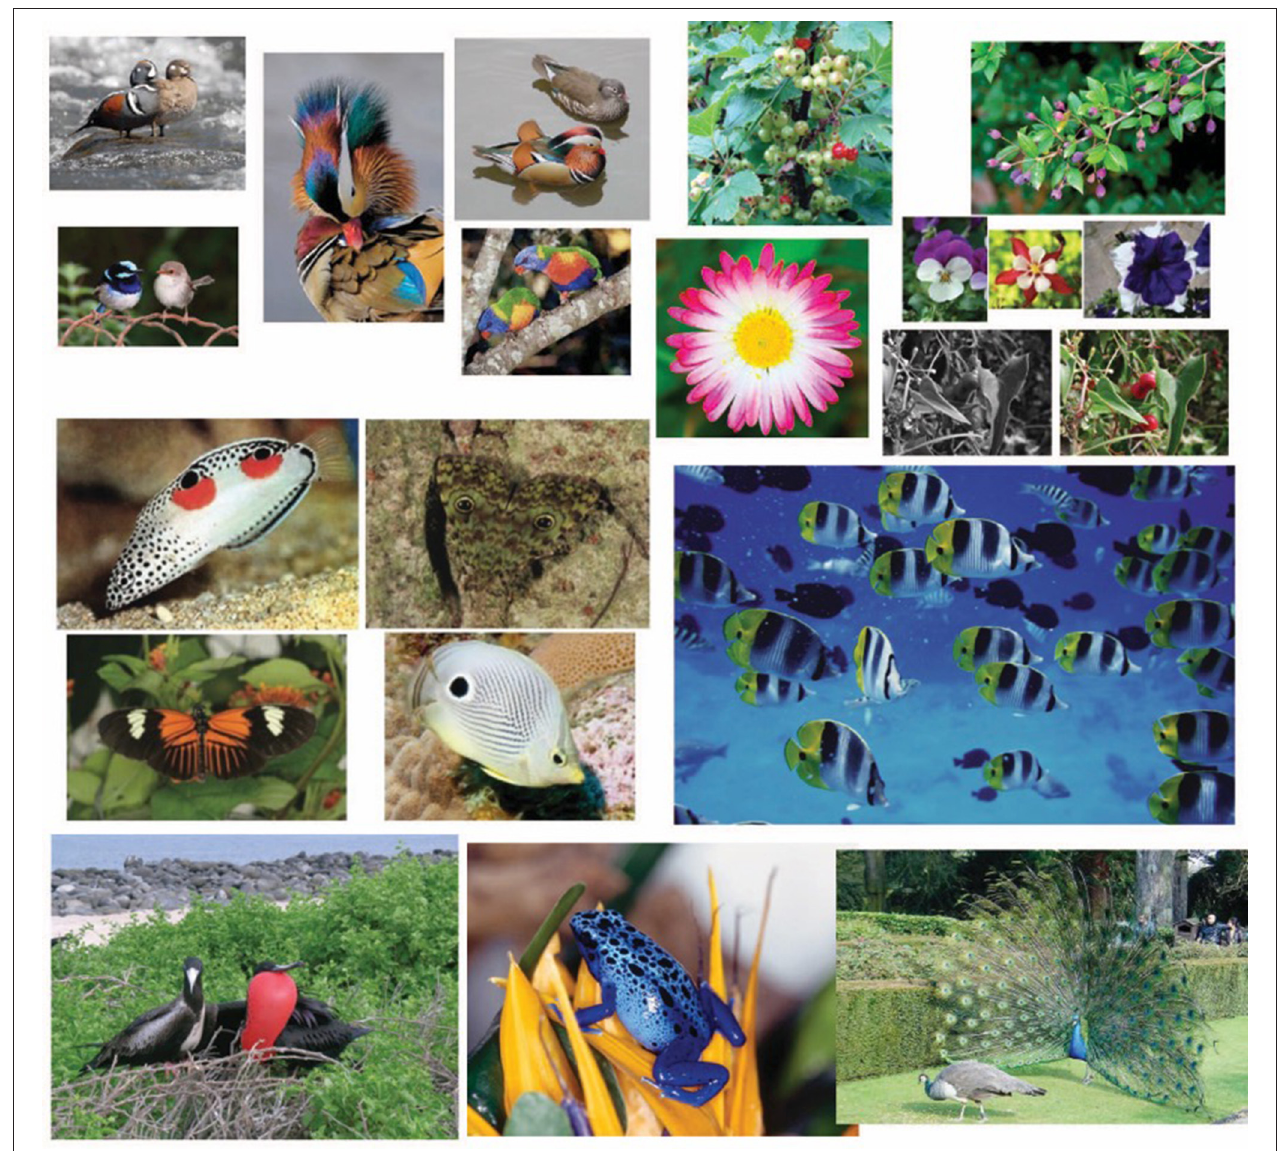
FIGURE 14 | Biological implications of accentuation and of coupling: Masking and unmasking effects in animals due to the principle of accentuation.